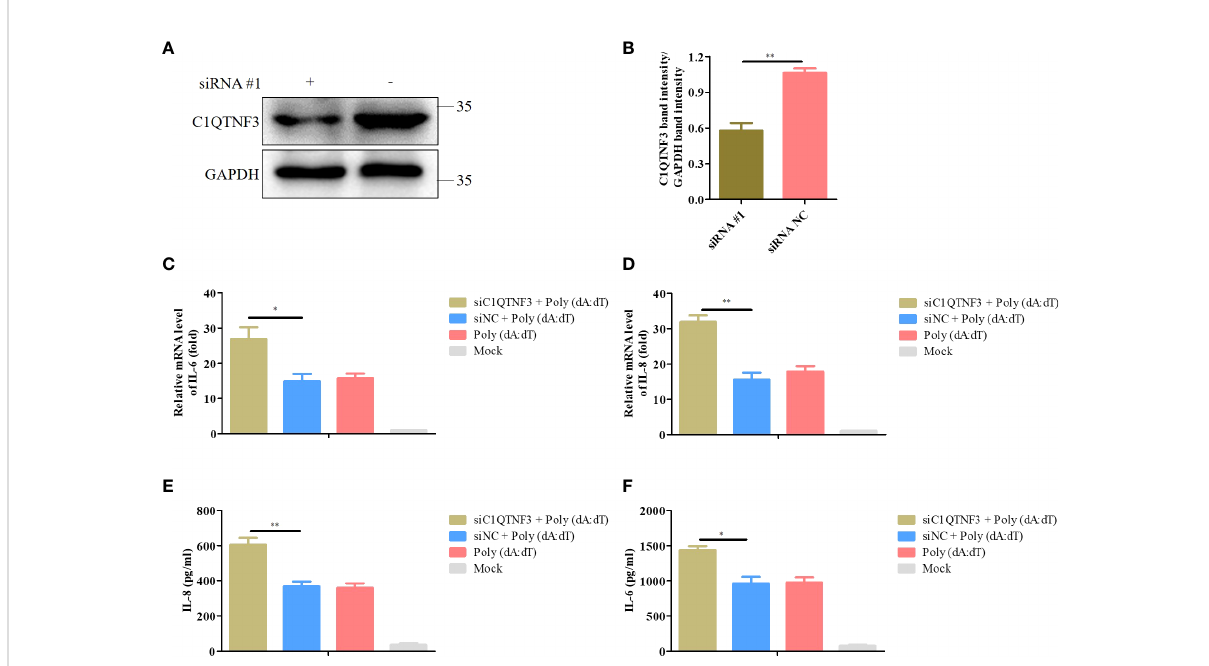
FIGURE 8 Knockdown of C1QTNF3 increases poly (dA:dT)-induced in fl ammatory cytokine production in PK-15 cells. (A, B) Detection of C1QTNF3 siRNA knockdown ef fi ciency using western blot analysis. The mRNA levels of (C) IL-6 and (D) IL-8 in PK-15 cells with C1QTNF3 downregulation for 24 h followed by poly (dA:dT) stimulation for 48 h. The GAPDH gene was used as the internal control for normalization. The 2 - DD Ct method was used to analyze the results of qPCR. The protein levels of (E) IL-8 and (F) IL-6 in PK-15 cells with C1QTNF3 downregulation for 24 h followed by poly (dA:dT) stimulation for 48 h p <0.05 (*), p < 0.01